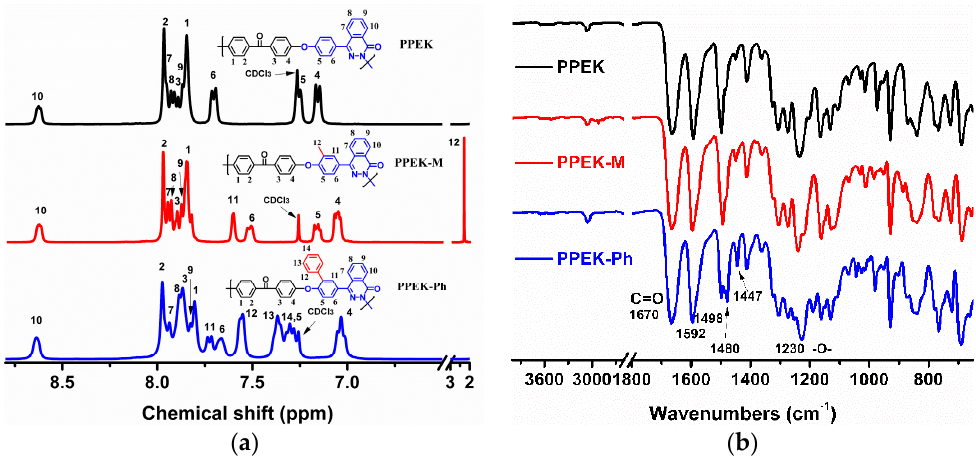
Figure 1. ( a ) The 1 H NMR spectrum of PPEKs and ( b ) the FTIR (right) spectrum of PPEKs.